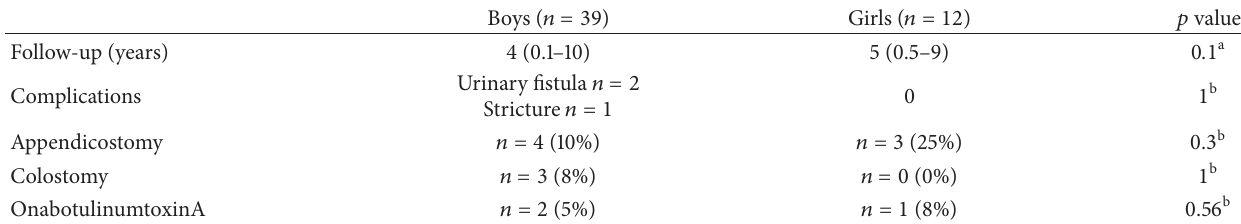
Table 5: Long-term follow-up data, median (range), 𝑛 :